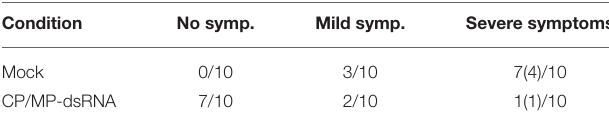
Plants were challenged with the virus 3 days after the dsRNA application. Parenthesis means dead plants.